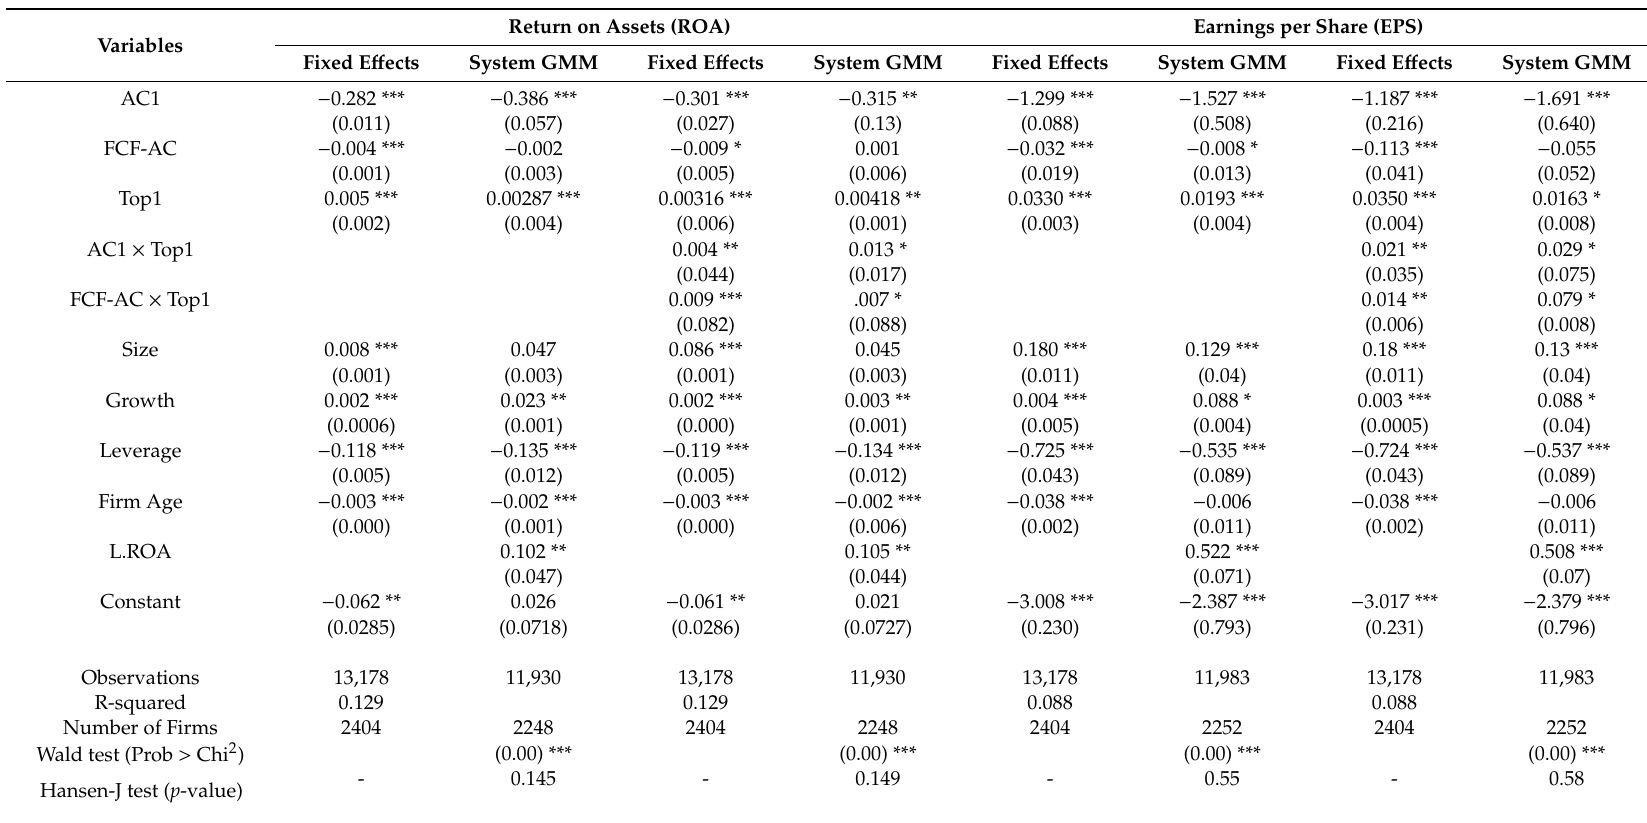
Table 6. Moderating e ff ect of CGQ on agency costs and firm